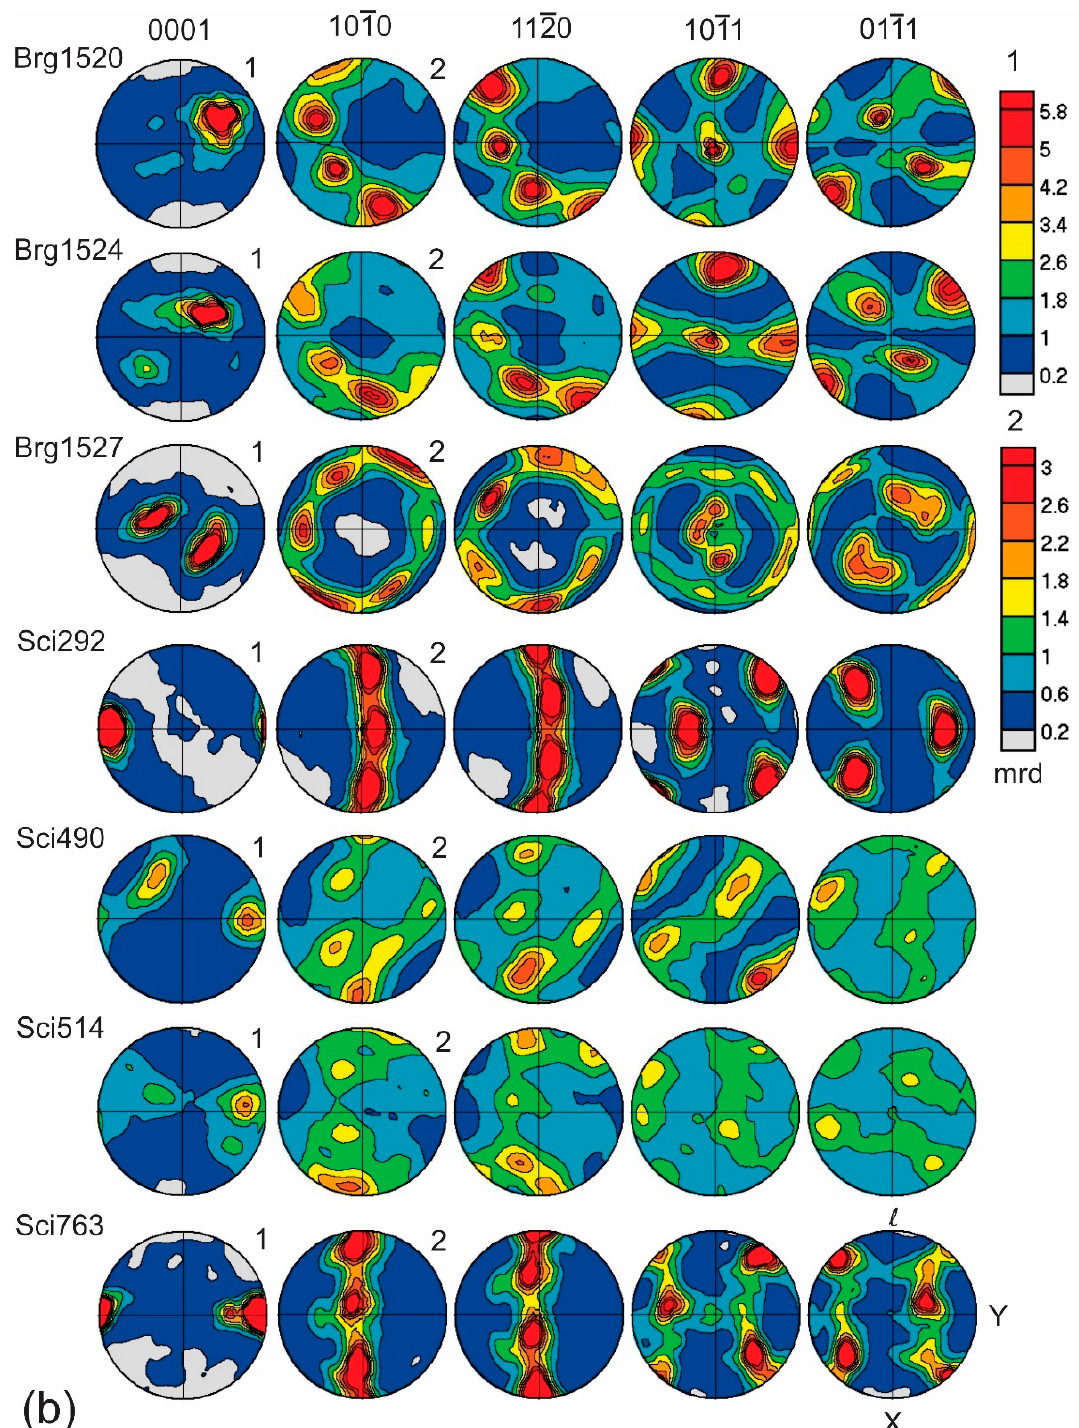
Figure 8. Neutron pole figures for quartz layers. Equal area projection on the schistosity plane. Lineation is l . Numbers on top right of pole figures indicate which pole density scale was used (in mrd). The scale in the second column was also applied to Columns 2–5. The order of samples is the same as in Table 1. The 14 samples are divided into two figures, ( a ) and ( b ).